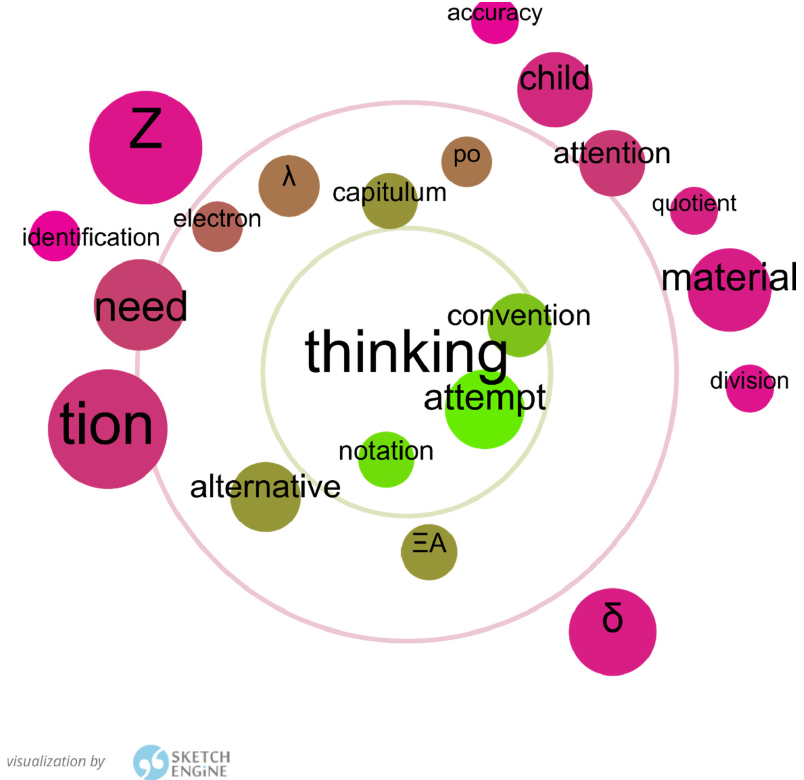
Figure 4. Terms semantically close to “thinking” in Turing’s corpus.